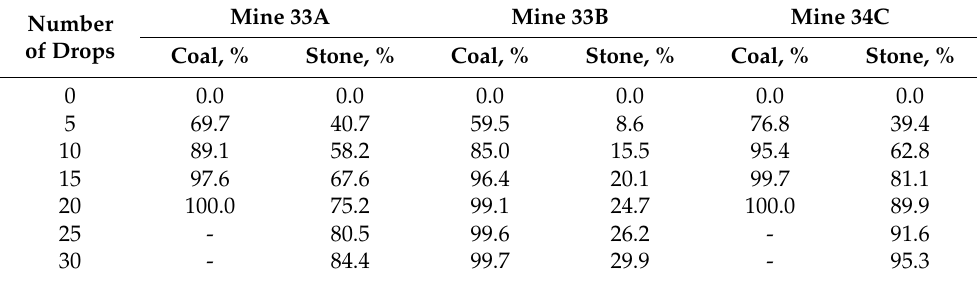
Table 2. Output of 80-0 mm class depending on number of drops—comparative results for coal type 34 [43].